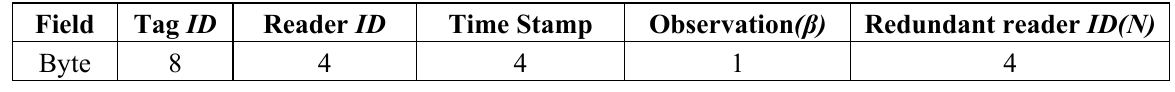
Table 2. Structure of the tag list stored in the cluster